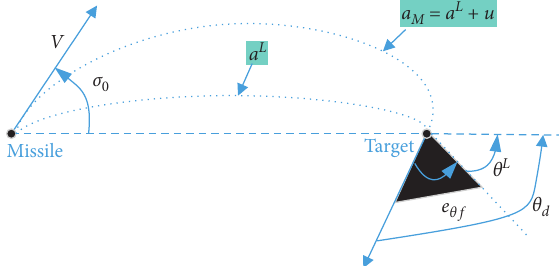
Figure 2: The purpose of introducing the bias term u